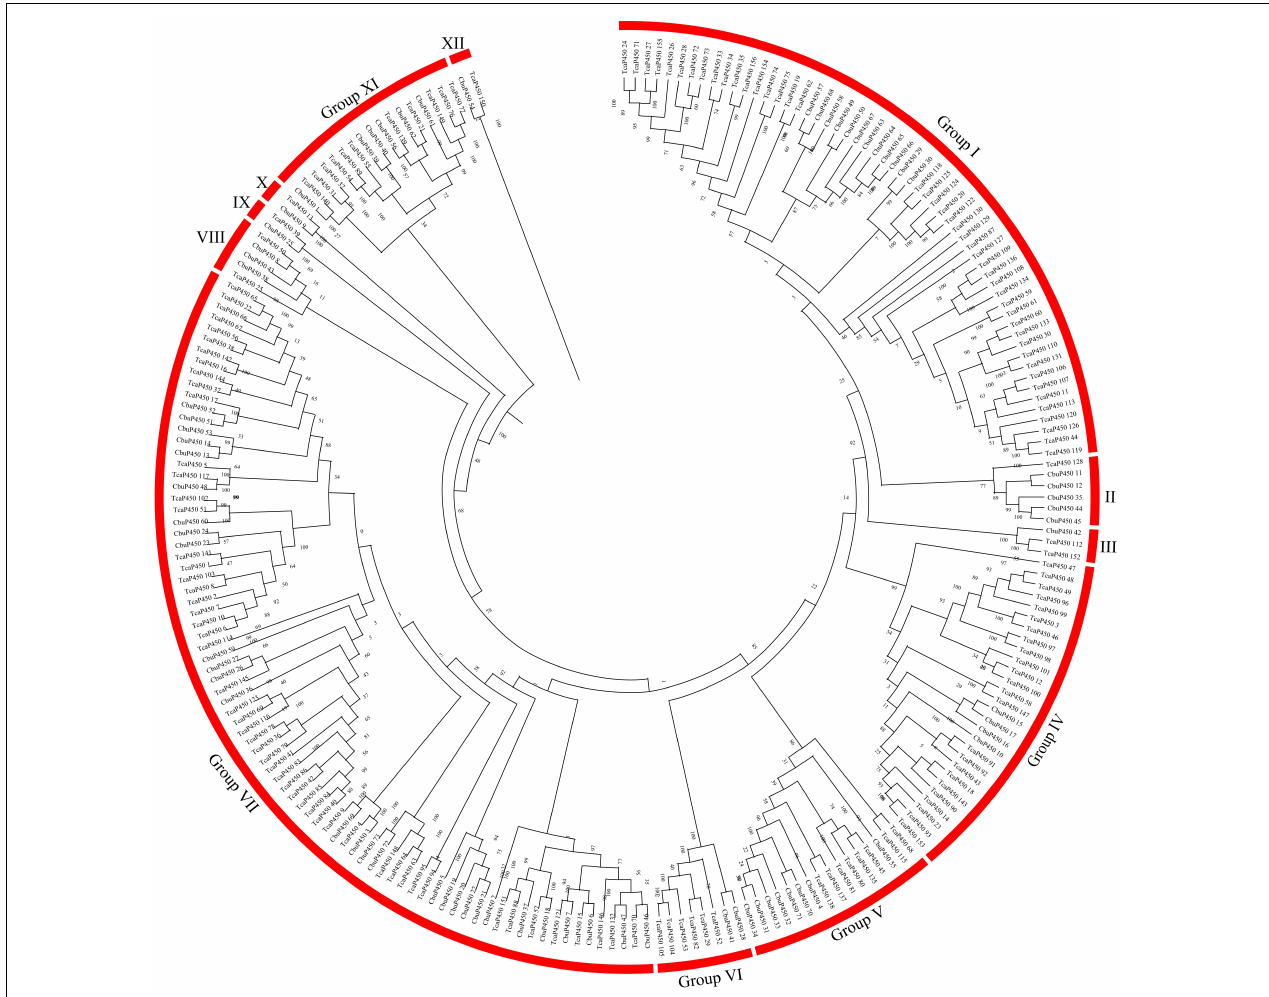
FIGURE 5 | Phylogenetic tree of P450s in C. buqueti ( C. buqueti , Cbu) and red flour beetle ( T. castaneum , Tca) genome.